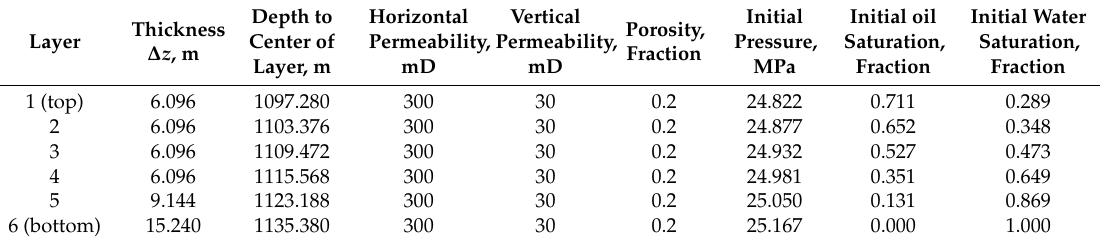
Table 6. Reservoir data and initial conditions of the case used to validate the designed simulator.